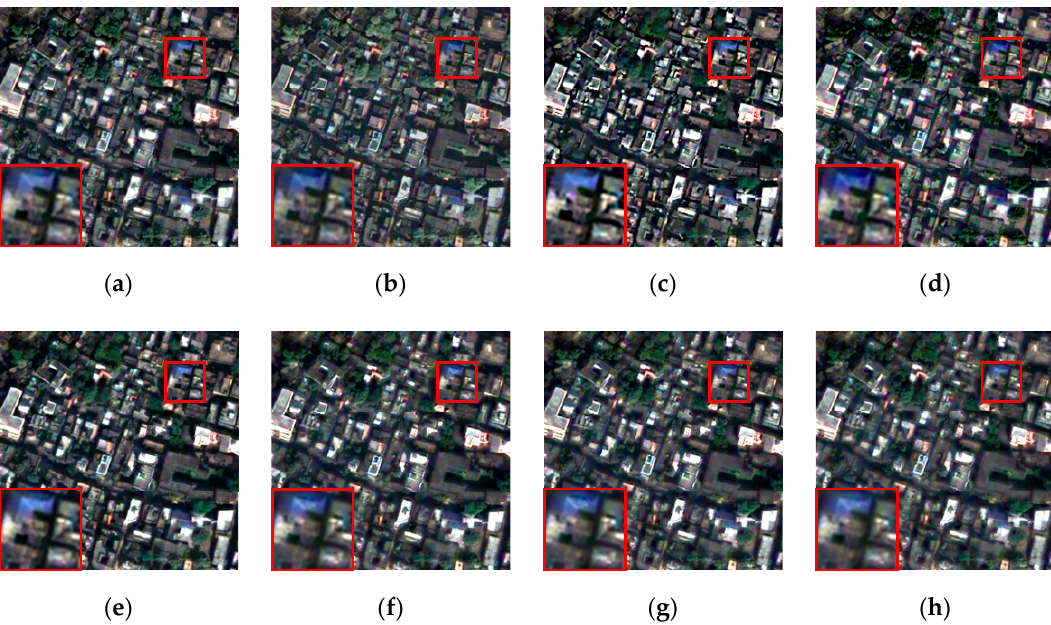
Figure 10. Fusion results of real data set from the QuickBird satellite: ( a ) ATWT; ( b ) GS; ( c ) MTF-GLP-CBD; ( d ) BDSD; ( e ) MF-HG; ( f ) GSA-BPT; ( g ) GSA-HA; and ( h ) proposed method.